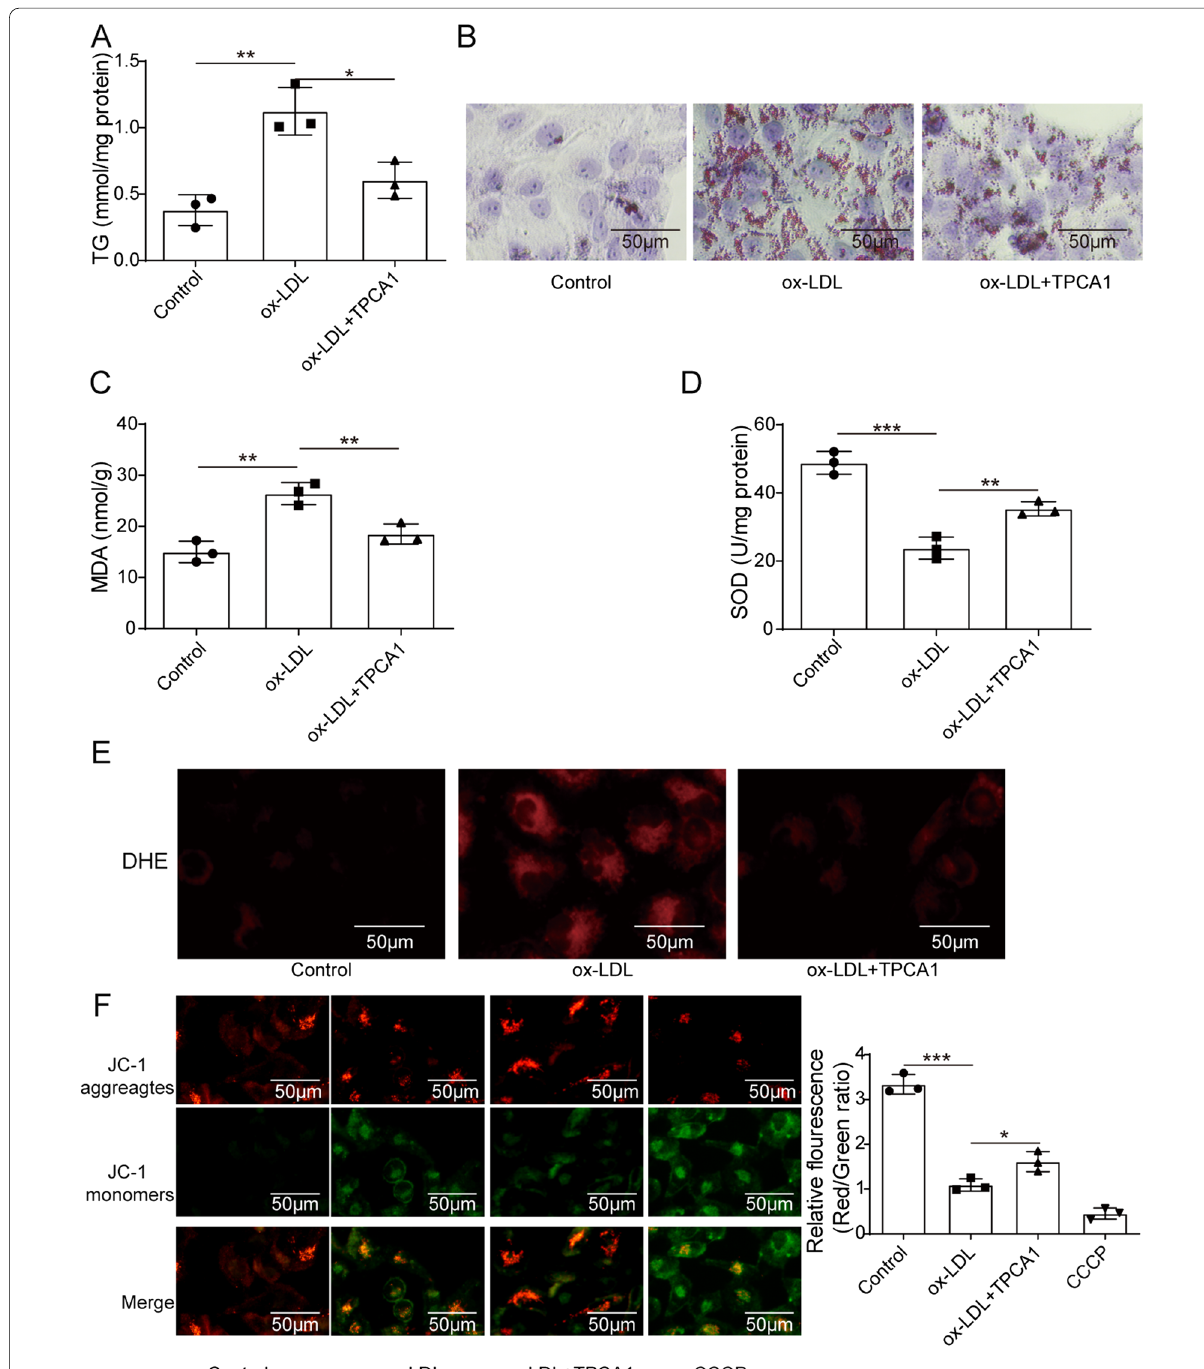
Fig. 3 IKK inhibitor alleviated lipid deposition and oxidative stress injury in cells exposed to ox‑LDL. HK‑2 cells were exposed to ox‑LDL to construct a cell model. TPCA1 acted as an IKK inhibitor. Cells were divided into three groups: control, ox‑LDL, and ox‑LDL cells. B Representative Oil Red O staining of HK‑2 cells in different groups. C and D qRT–PCR analysis of MAD levels and SOD activity in HK‑2 cells in different groups. E DHE staining of intracellular ROS levels. F ΔΨm was measured using the JC‑1 assay in treated HK‑2 cells. IKK, IκB kinase; ox‑LDL, oxidized low‑density lipoprotein; HK‑2, human kidney 2; TPCA‑1, 2‑[(aminocarbonyl)amino]‑5‑(4‑fluorophenyl)‑3‑thiophenecarboxamide; TG, triglyceride; qRT–PCR, real‑time quantitative reverse transcription PCR; MAD, malondialdehyde; SOD, superoxide dismutase; DHE, dihydroethidium; ROS, reactive oxygen species; ΔΨm, mitochondrial membrane potential. Significance was assessed by an ANOVA test. The experimental data are shown as the mean SD. N 3. *P < 0.05, **P < 0.01, ***P < ± =